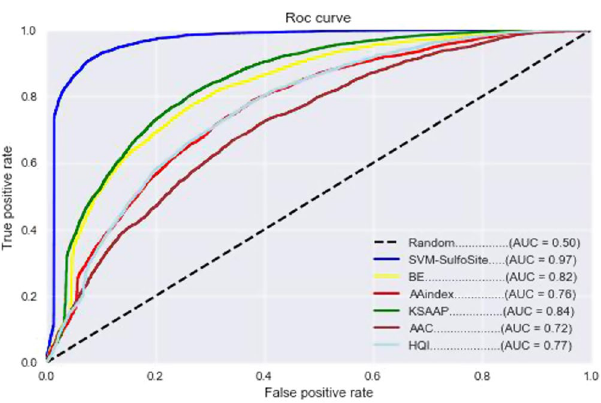
Figure 2. Receiver operator characteristic (ROC) curves for each of five features used to develop our method as well as that for the final method utilizing all features (SVM-SulfoSite) for the 10-fold cross-validation. The area under the curve (AUC) for each feature is given in